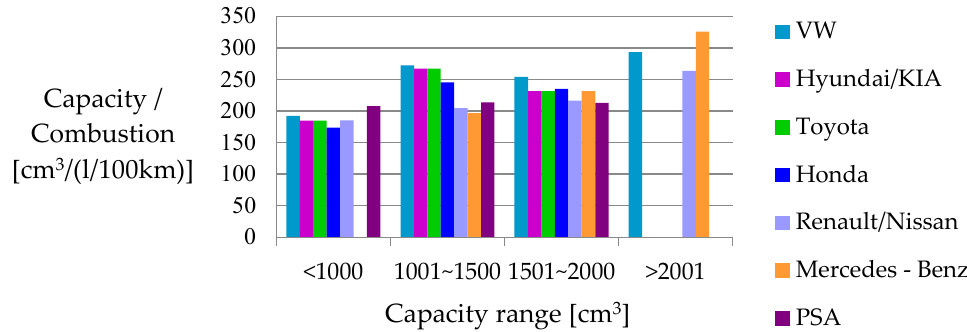
brands. Source: Developed own.